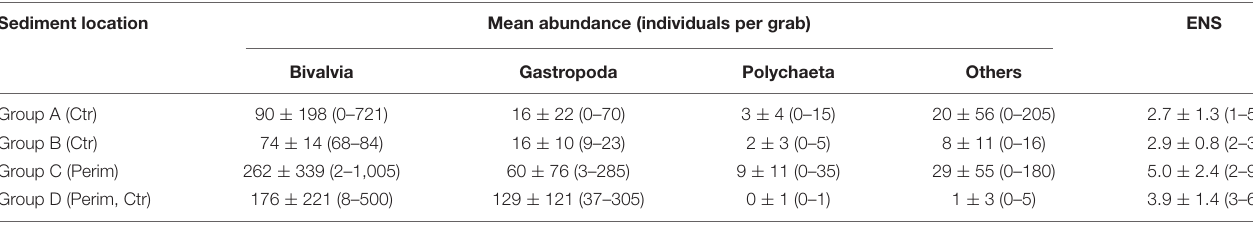
TABLE 3 | Average means ± standard deviations and (ranges) for abundances of bivalves, gastropods, polychaetes and others as well as the effective number of species (ENS) for the four groups identified from hierarchical cluster analysis of sediment deposits sampled in triplicate from the Indian River Lagoon, Florida. Sediment location Mean abundance (individuals per grab)